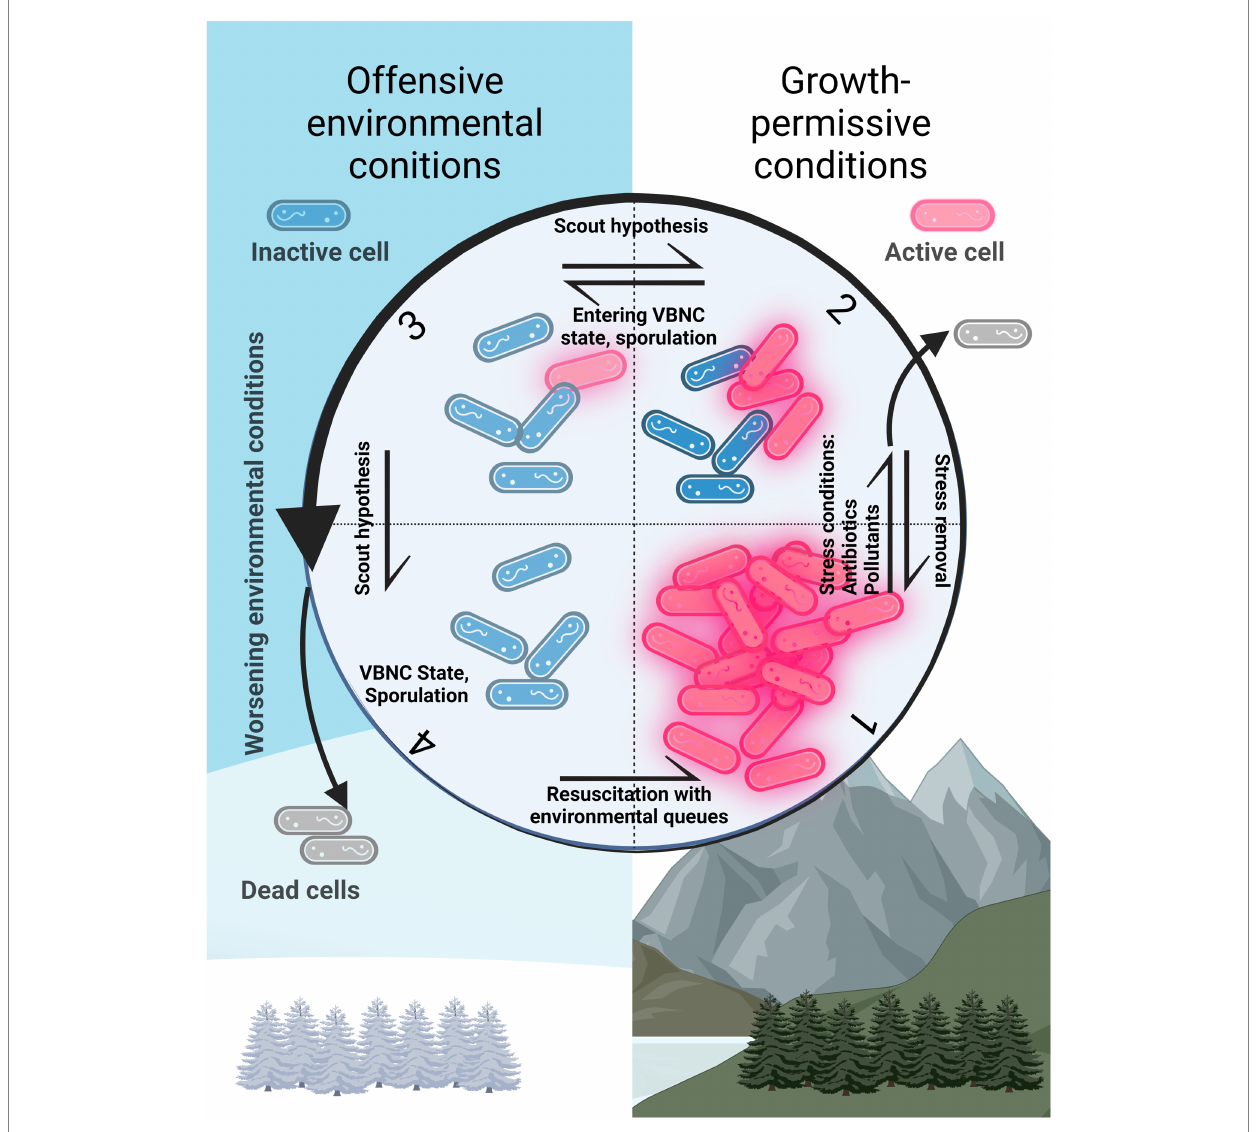
FIGURE 1 Different activity states of cells in the environment. 1: Active community or population. 2: In the presence of substances such as pollutants and antibiotics, a portion of the population dies and some cells can persist. These latter cells can then divide again when the substance is removed. 3: Cells in the viable but non-culturable state (VBNC). If a cell stochastically awakens in growth-permissive conditions (section number 2), the population starts replicating. If not, the cells die off (section number 4). 4: Cells in the VBNC state. Cells can resuscitate if environmental conditions become growth- permissive again (section number 1). This represents the resuscitation mediated by present environmental queues. Created with